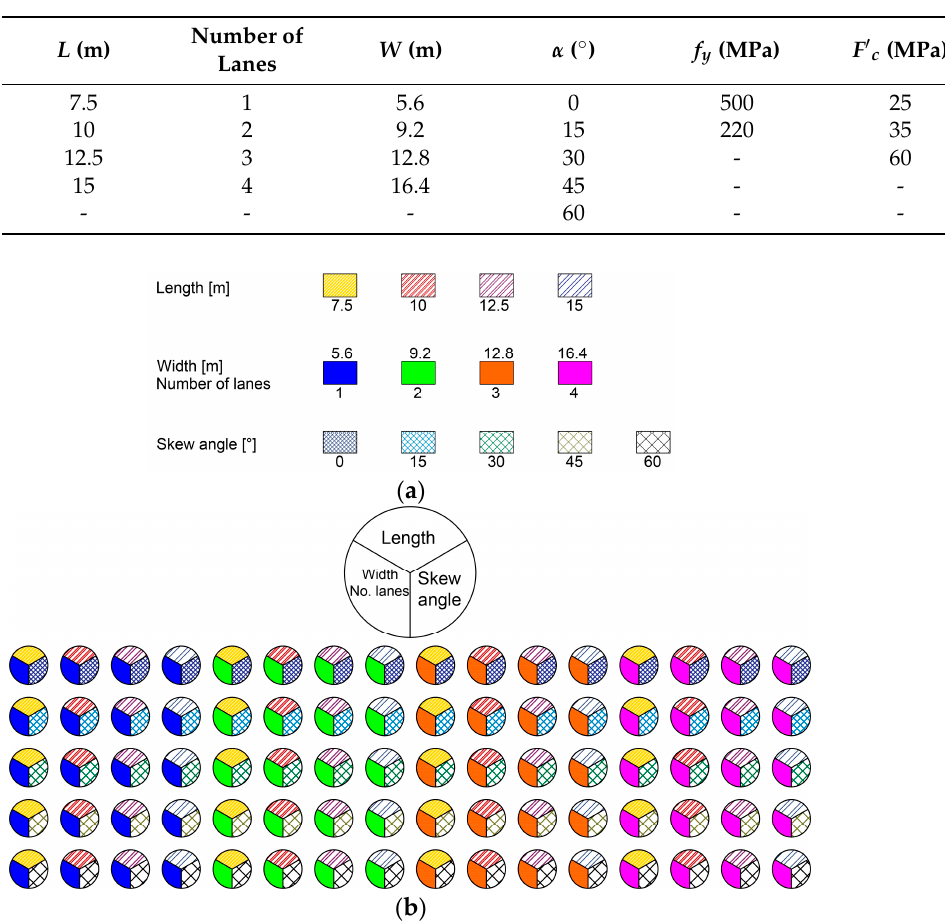
Table 1. Overview of parameters studied.